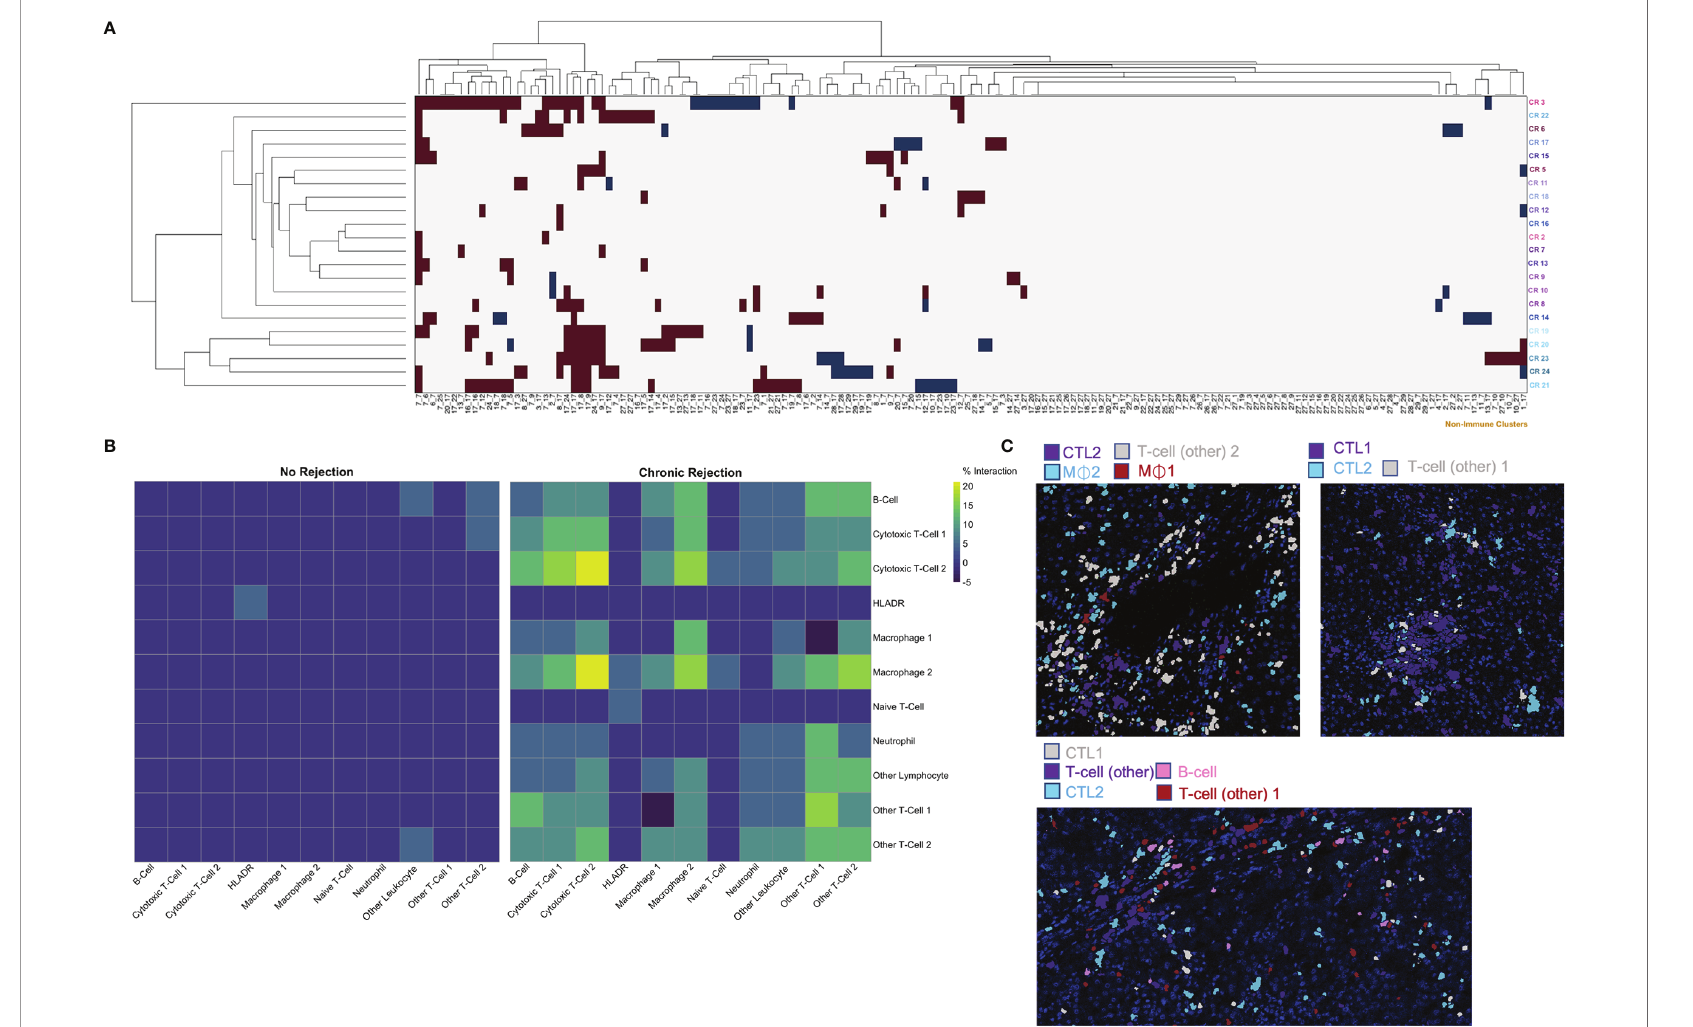
FIGURE 5 | Characterization of spatial relationships between immune subpopulations mediating chronic liver transplant rejection. Phenograph meta-cluster data, including non-immune populations, were examined using neighborhood analysis, which identi fi es signi fi cant, pairwise interactions or avoidances between individual cells within a 4-pixel (4 m m) radius. (A) Clusterogram depicting individual ROI from patients with chronic rejection across each row, highlighting signi fi cant pairwise interactions (red) and avoidances (blue) based on cluster ID across all 29 Phenograph clusters, including 18 unique ‘ non-immune cell ’ clusters, enables visualization of signi fi cant interactions and avoidances across the entire dataset (Histocat, 99 permutations, p<0.05). (B) This visual representation was further narrowed to focus exclusively on immune subpopulations using neighbouRhood in R (5000 permutations/p<0.01). Immune cell interactions were rare in liver with no rejection, while several strong interactions were noted in chronic rejection. Color scale shows percentage of signi fi cant interaction events. (C) Representative images were pseudocolored to highlight immune populations with signi fi cant interactions, including Cytotoxic T-cell-2 with Macrophage-1 and Macrophage-2, as well as interactions between Cytotoxic T-cell-1 and Cytotoxic